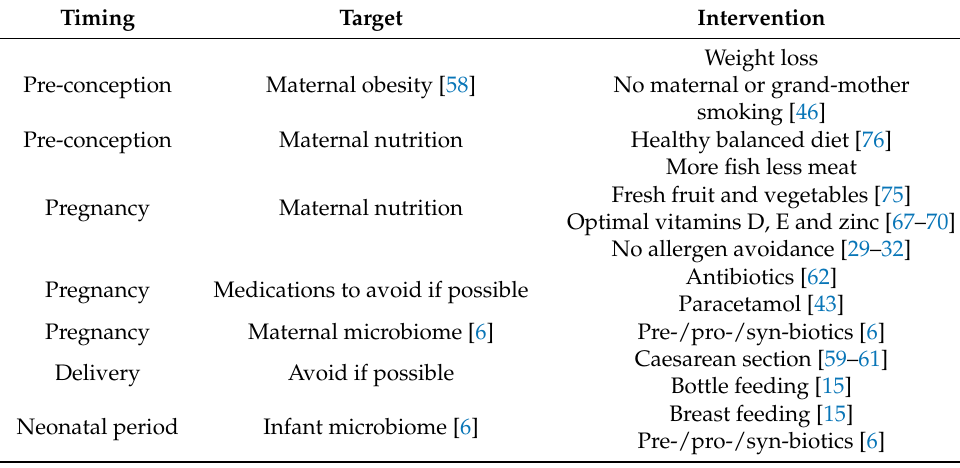
Table 1. Tabulation of the most promising interventions to prevent allergic disease based on pub- lished observational and interventional studies focusing on the first 1000 days. Published evidence referenced in brackets. However, before recommending any interventions it will not only be nec- essary to demonstrate worthwhile benefit but also to be mindful of potential adverse effects. For instance, paracetamol is the only mild to moderate analgesic recommended for use in pregnancy, while antibiotics for bacterial infection in pregnancy and caesarean section are sometimes essential for medical reasons. Based on all the published evidence, a “healthy diet” would appear to be the best and most practicable option, pre-conception, during pregnancy and